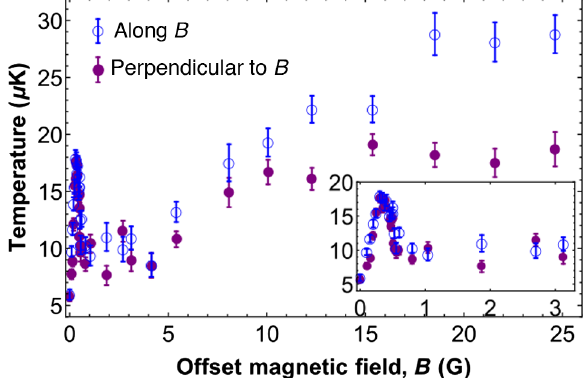
FIG. 4. Temperature under a uniform B applied along z , with I ¼ 3 . 2 I 0 , Δ ¼ 8 . 3 Γ , and δ ¼ 0 . The blue open circles (purple filled points) represent the temperature measured along (trans- verse to) B . The inset shows the temperature from 0 to 3 G.